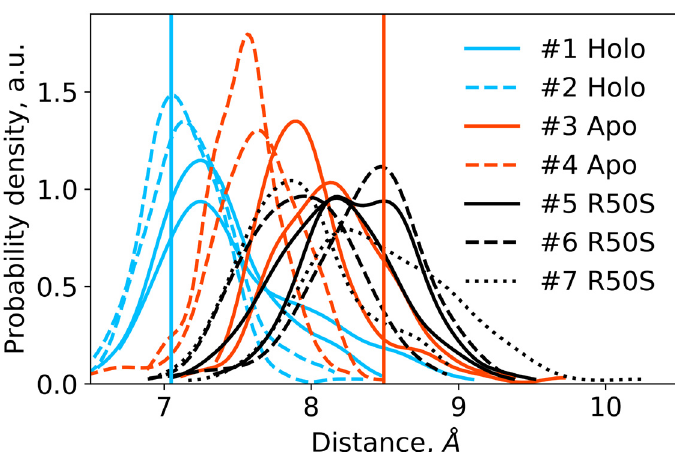
Figure 4. Distances between the backbone C α atoms of the residues Arg50 or Ser50 and Asp133 within each protomer in the last 200 ns of the simulations. For each trajectory, two distributions are shown, with each one corresponding to a single protomer. The distances are indicative of intact hydrogen bonds between Arg50 and Asp133 in the WT protein and broken hydrogen bonds between Ser50 and Asp133 in the R50S mutant. Vertical lines show the respective distances in the crystallographic structures: the values for the symmetric ligand-bound WT structure (PDB ID 5IJI) are shown in cyan, the values for the symmetric ligand-free WT structure (PDB ID 5JEQ) are shown in orange.